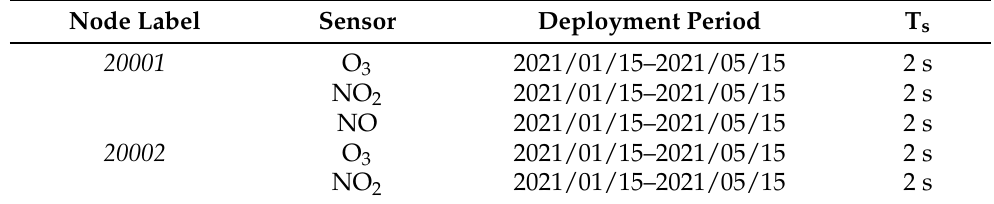
Table 2. Description of the datasets used for the experiments. T s is the sensor sampling period. Node Label